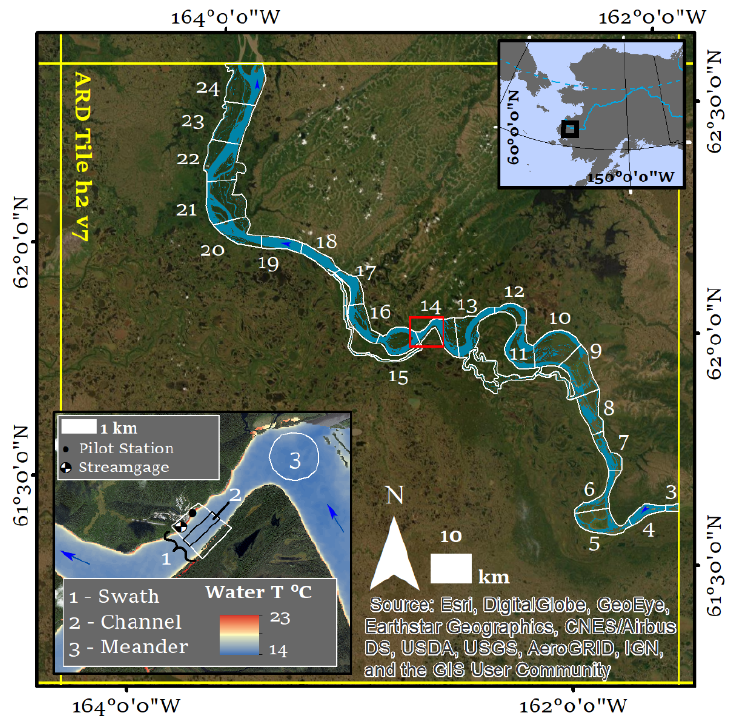
Figure 1. Study area showing location with respect to Alaska and the Yukon River (upper inset), distribution of river segments, and the extent of the Swath, Channel, and Meander AOIs with respect to the USGS streamgage located in Pilot Station (lower inset).